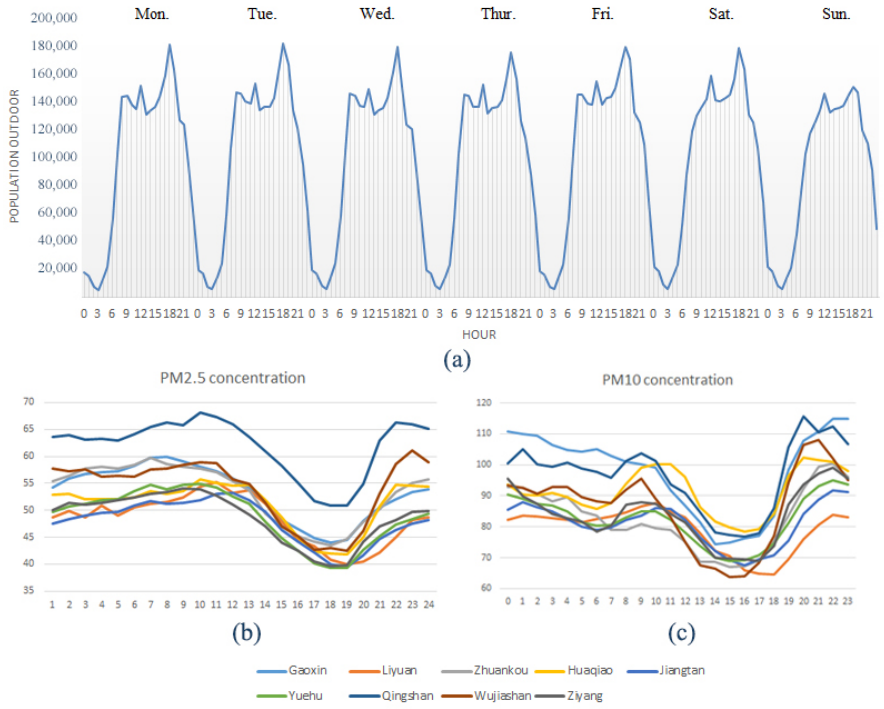
Figure 3. Time series for hourly population ( a ) and hourly average PM 2.5 and PM 10 concentrations ( b , c ).